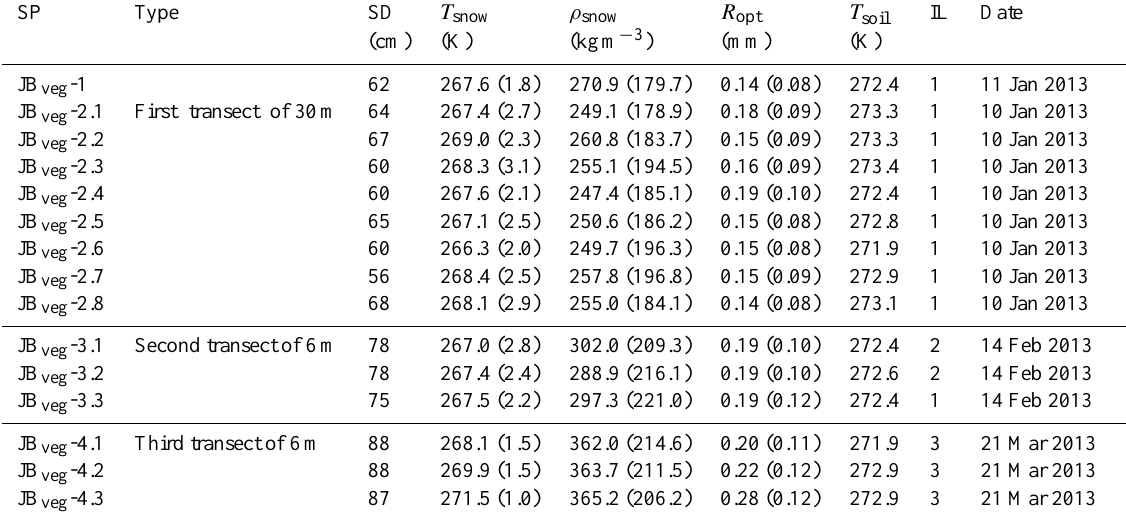
Table 4. Same as Table 1 but for James Bay sites, all in forested areas (JB veg ) . SP Type